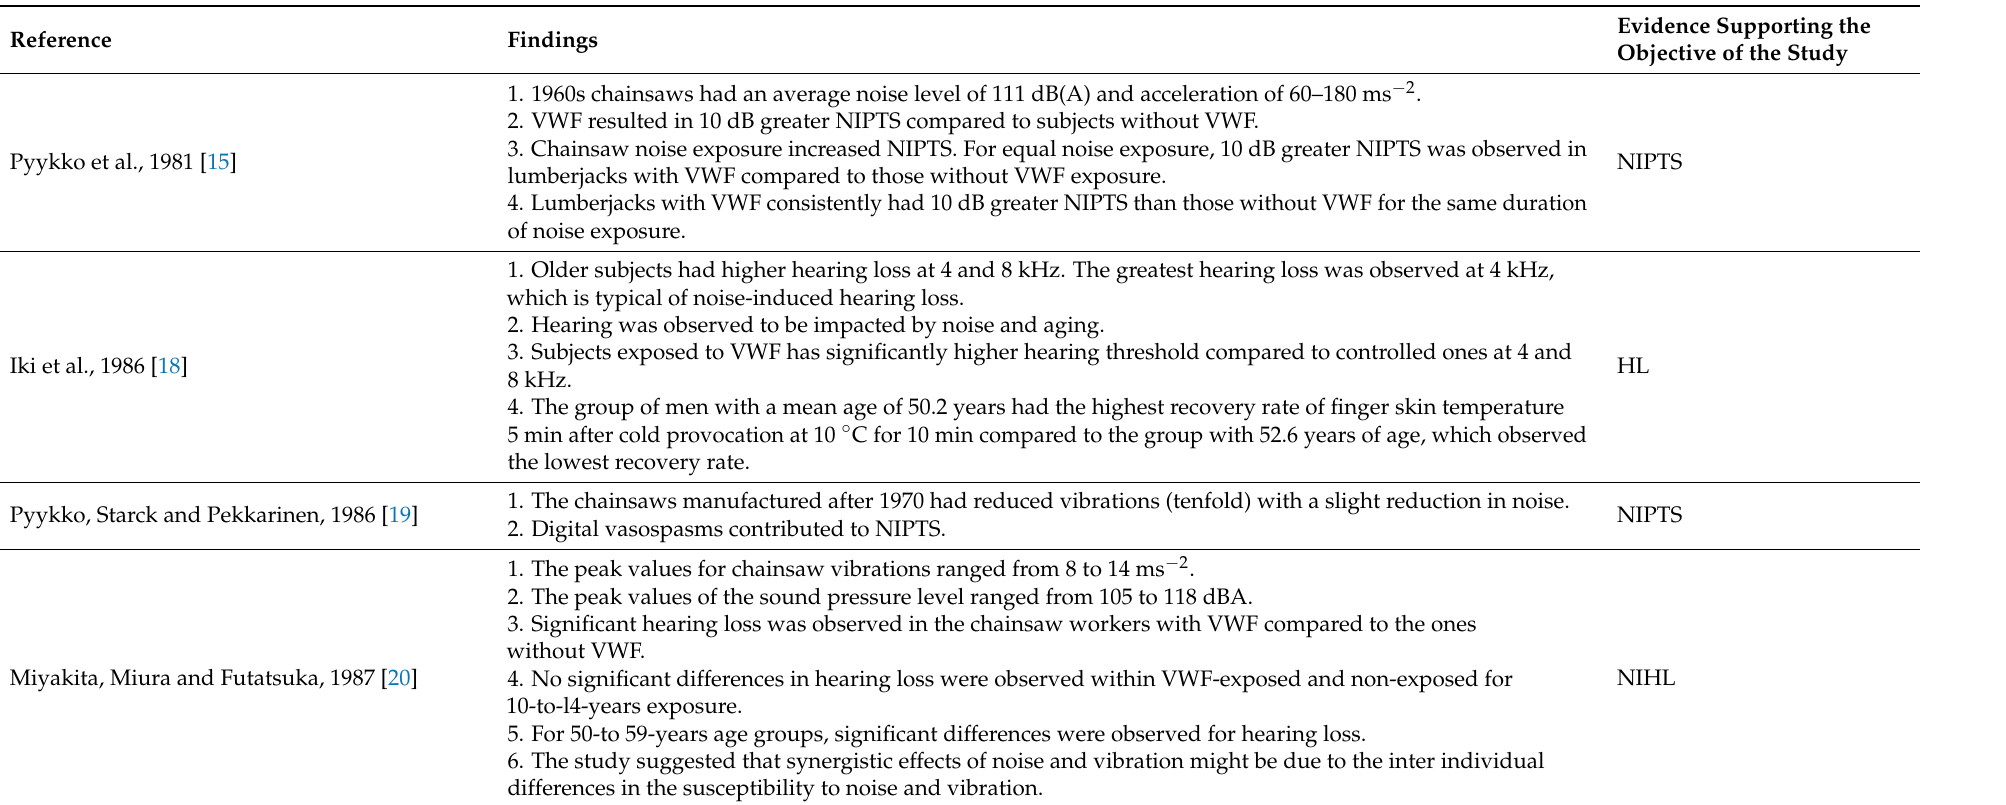
Table 3. Brief Summary of Study Findings (HAV—Hand Arm Vibration, WBV—Whole Body Vibration, NIPTS—Noise Induced Permanent Threshold